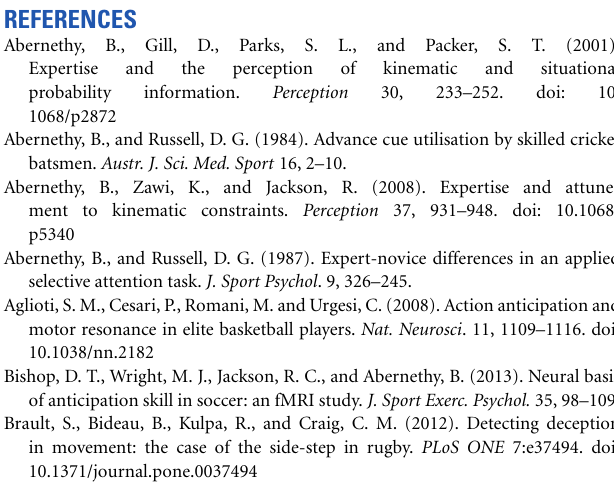
across task types (deception identification and direction identification) and occlusion levels (0ms, − 160ms). Second-level group analysis is based on first-level contrasts between identification tasks and NBM